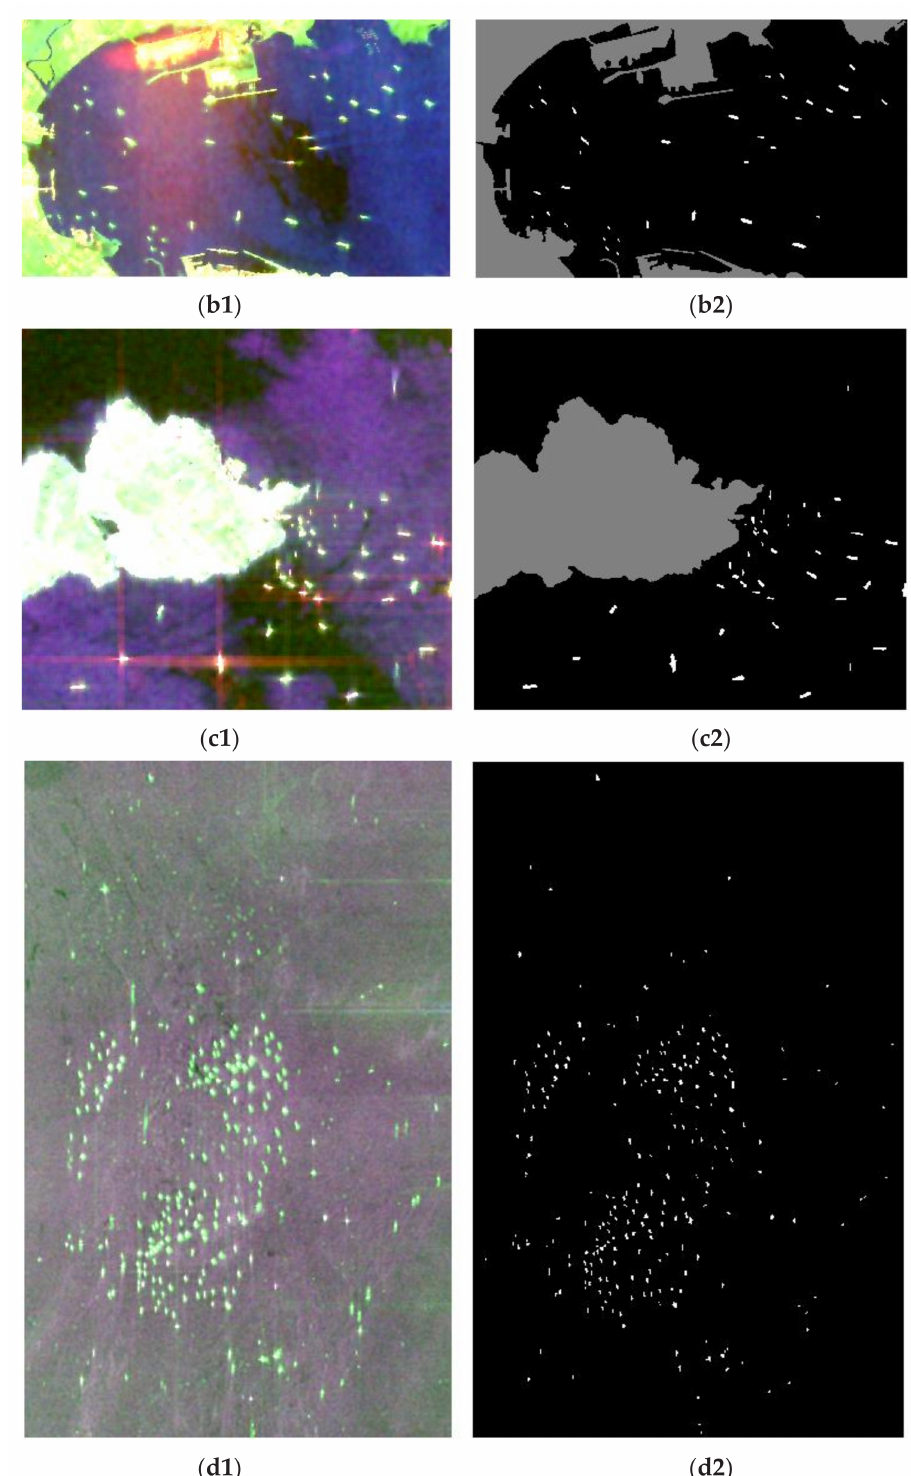
Figure 7. Experimental datasets. ( a1 , a2 ) Radarsat-2 area I data. ( b1 , b2 ) Radarsat-2 area II data. ( c1 , c2 ) GF-3 area I data. ( d1 , d2 ) GF-3 area II data. The numbers 1 and 2 indicate the Pauli RGB images and ground-truth images,